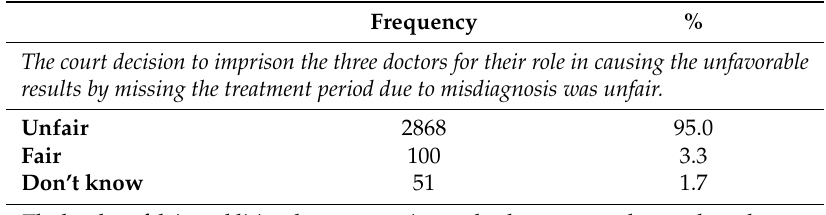
Table 3. Knock-on effects following the imprisonment